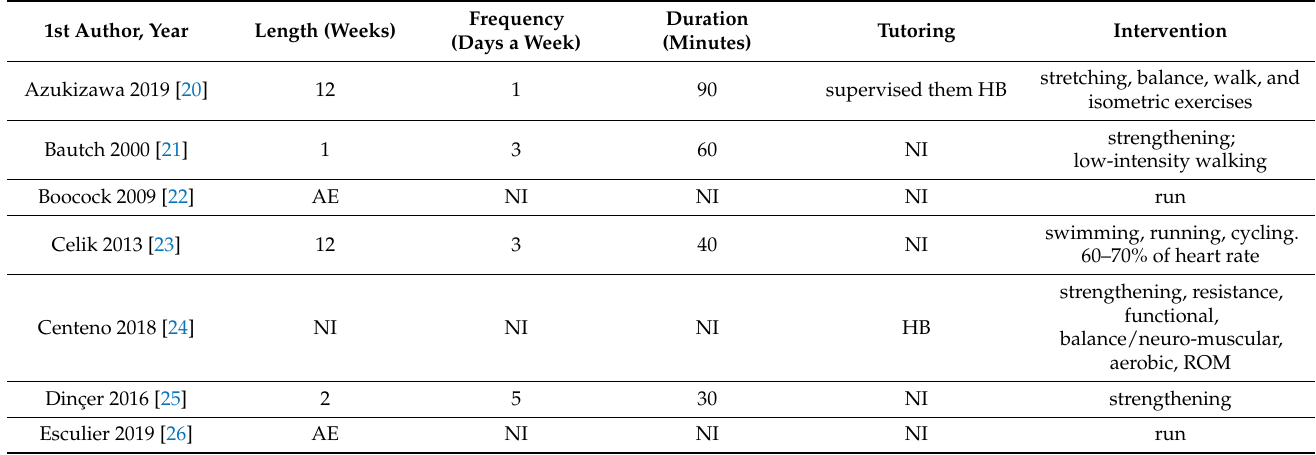
Table 2. Characteristics of the interventions adopted in the included